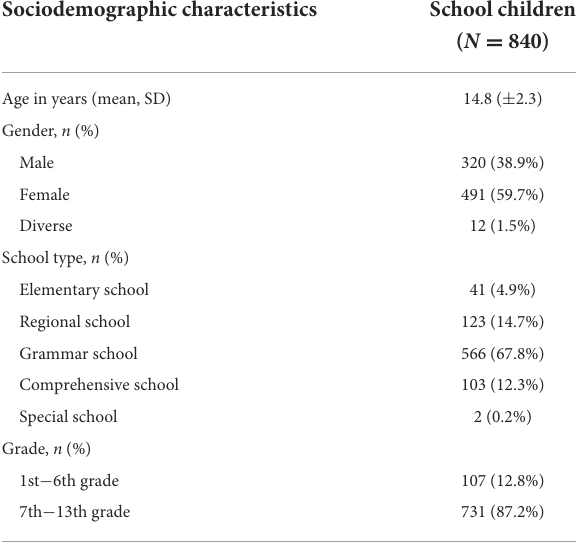
TABLE 1 Descriptive statistics for participating school children included in the